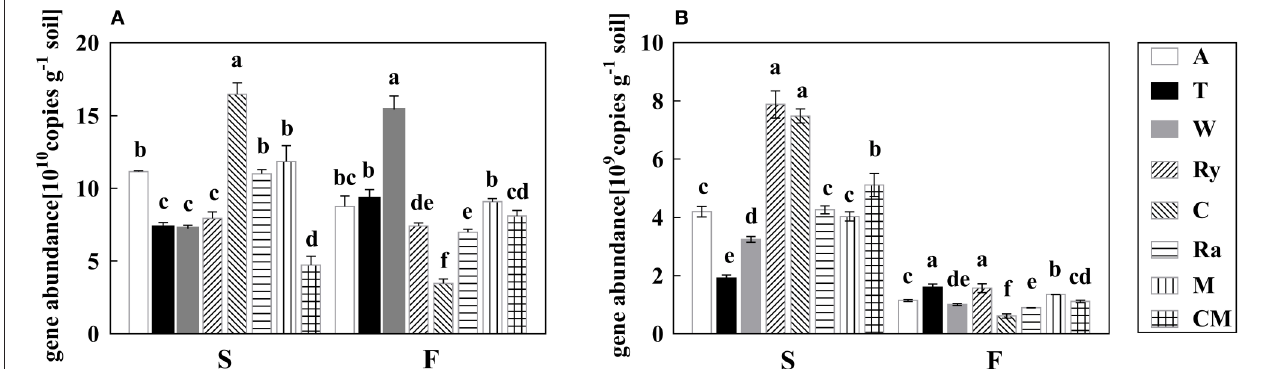
FIGURE 1 | The abundances of bacterial 16S rRNA gene (A) and fungal ITS gene (B) under different treatments in the spring (S) and fall (F) cropping seasons. Data with different letters in each column indicate significantly different between treatments at 0.05 level.